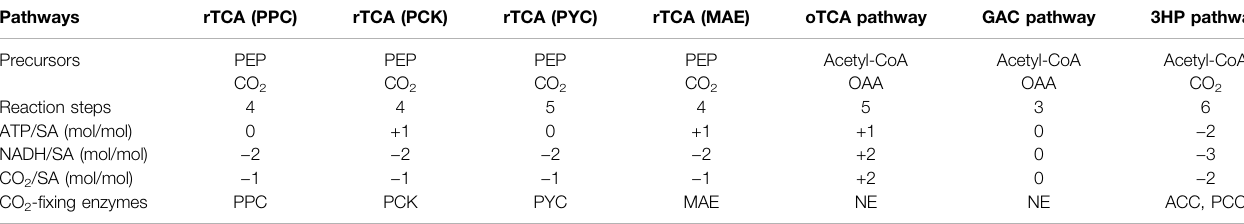
TABLE 1 | Comparison of different succinic acid biosynthetic pathways. Pathways